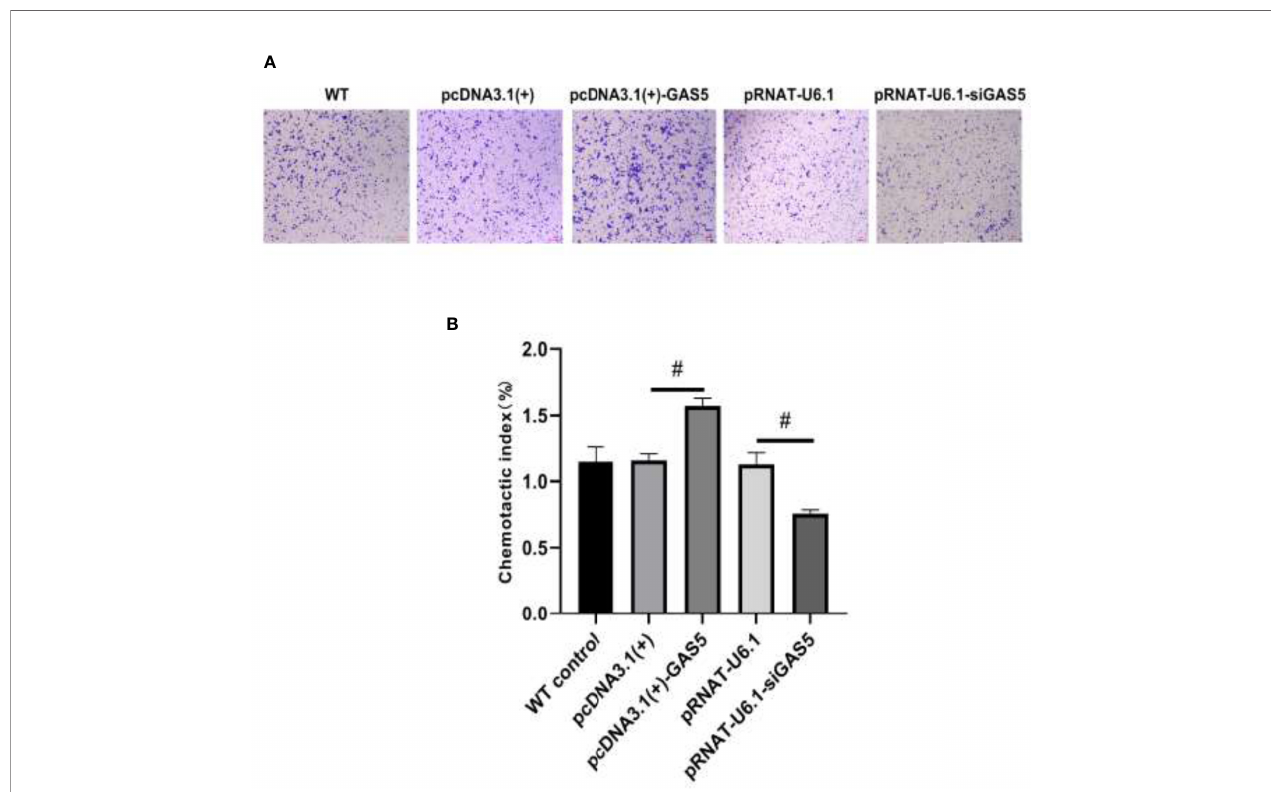
FIGURE 7 | GAS5 enhances the chemotaxis of RAW264.7. (A) The cytological morphology of RAW264.7 cells that migrated across the membrane. (B) Chemotactic index of RAW264.7. Statistical signi fi cance was determined by the Student ’ s t -test ( # p <